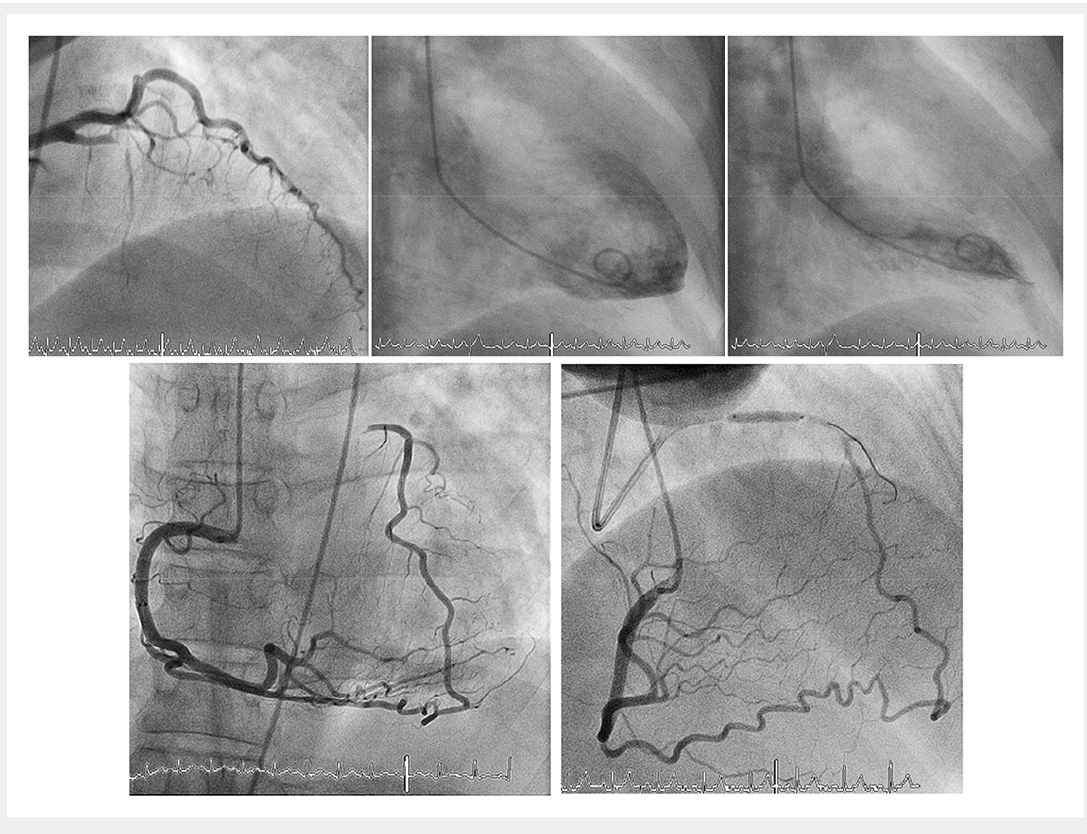
Figure 6 Completely normal left ventricular angiogram (top middle and right) due to extensive collateral supply of the proximally occluded left anterior descending artery via apical branch and septal collateral by the right coronary artery (bottom). Functional assessment is performed by balloon occlusion after recanalization of the chronic total occlusion (bottom right). (Data from Seiler C. Assessment and impact of the human coronary collateral circulation on myocardial ischemia and outcome. Circ Cardiovasc Interv. 2013;6:719–28 [86], with